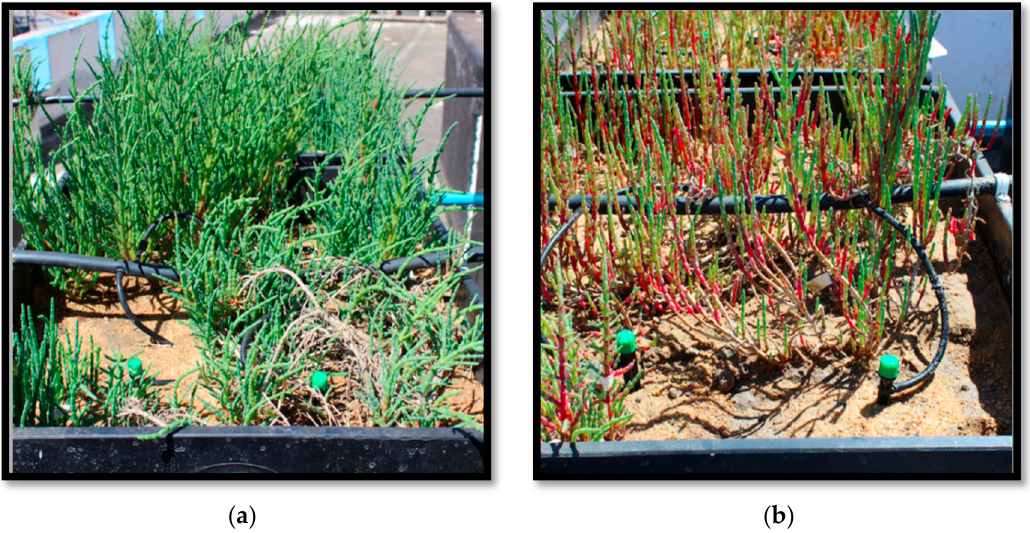
Figure 3. Picture of two lysimeters with Salicornia neei at the end of the experiment (day 74). Picture ( a ) plants irrigated with nitrate and ammonium (Nit + Amm). Picture ( b ) plants irrigated with sea-water (Control).